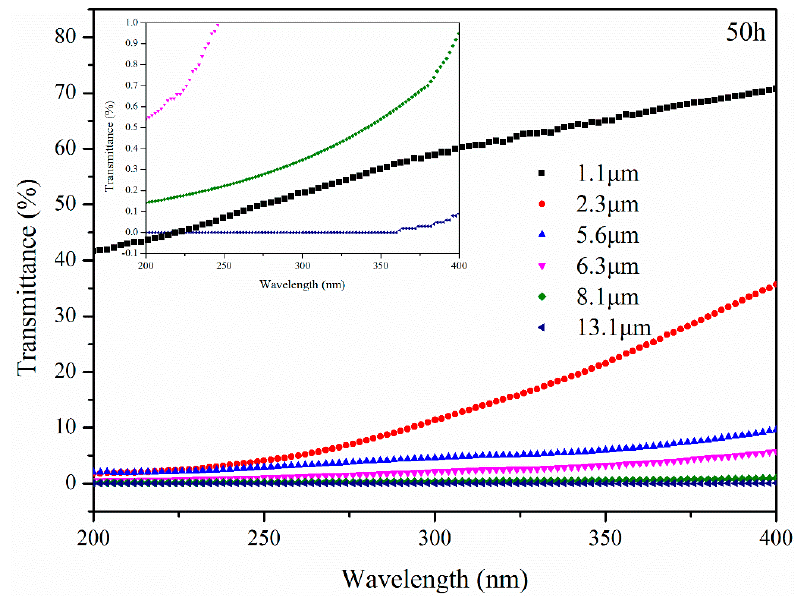
Figure 15. Transmittance of bitumen with different thickness after UV aging for 50 h.